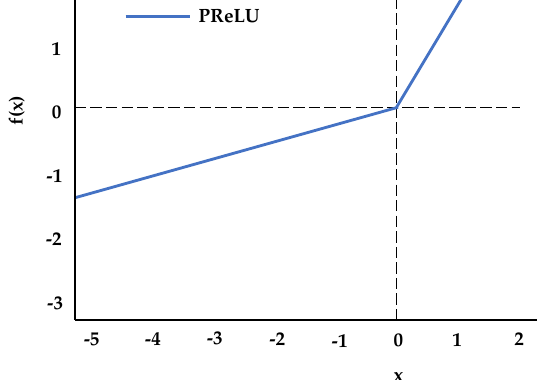
Figure 4. Activation function: parametric rectified linear unit (PReLU).